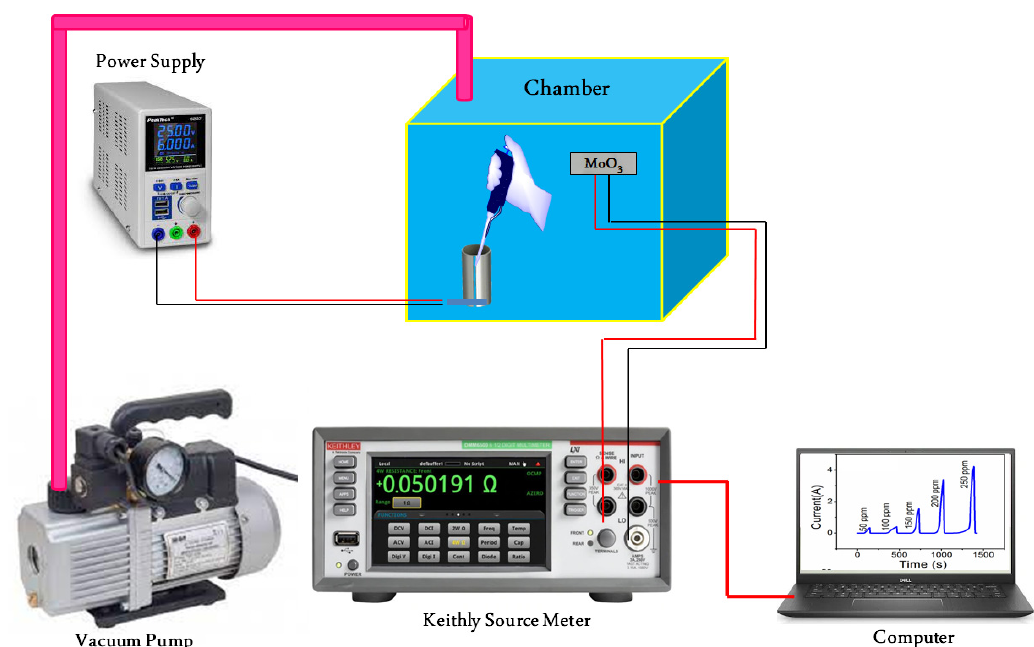
Figure 5. Schematic diagram of gas sensing setup for ammonia gas detection.